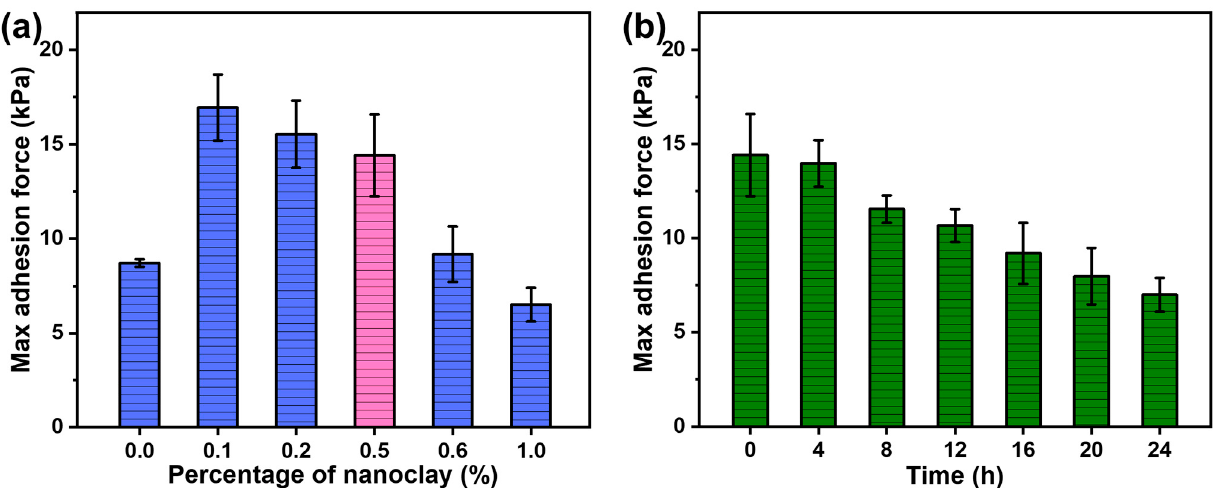
Figure 3. ( a ) Adhesive property for NEH with different percentage contents of nanoclay (The pink column is the selected nanoclay content for the following study.). ( b ) Comparison of adhesive property on the glass substrate for 24 h at 25 °C, 65% humidity.